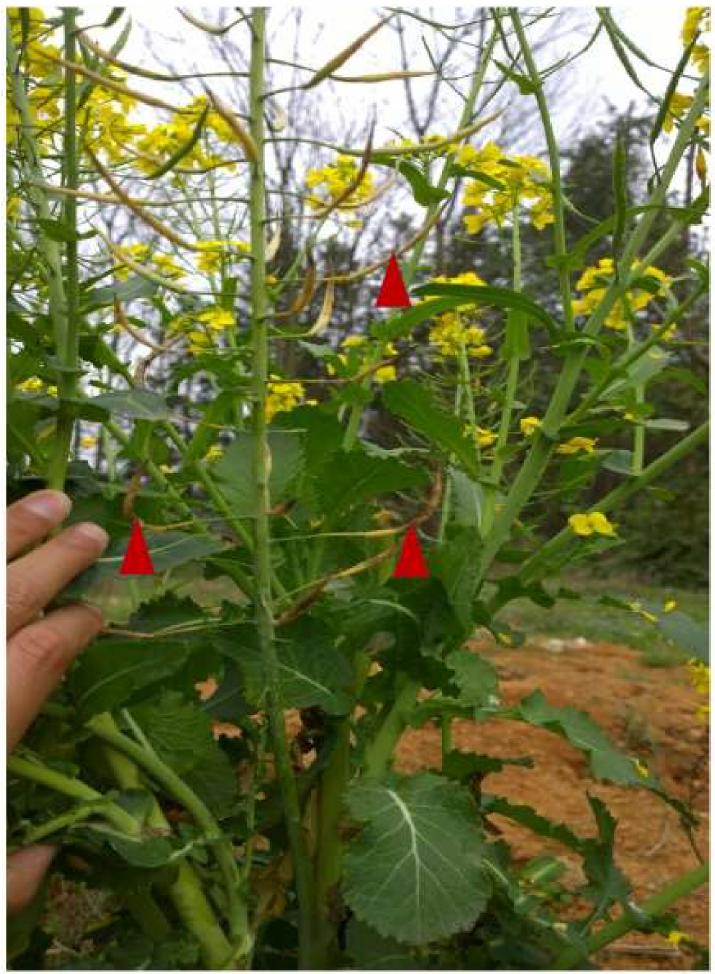
Figure 3. A rapeseed variety, LF9, with a longer flowering period than common B. napus by at least ten days. This variety can grow and bloom in batches; new branches grow up after old branches flower. Red triangles indicate old